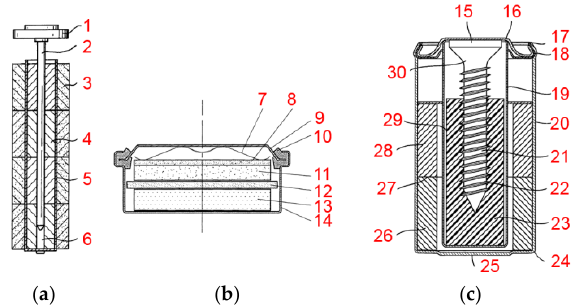
Figure 4. Schematics of ( a ) A multi-segment cylindrical cell, ( b ) A button cell, and ( c ) A hollow-cathode cylindrical cell from Varta. The parts are 1: terminal, 2: conducting pin, 3: positive electrode,